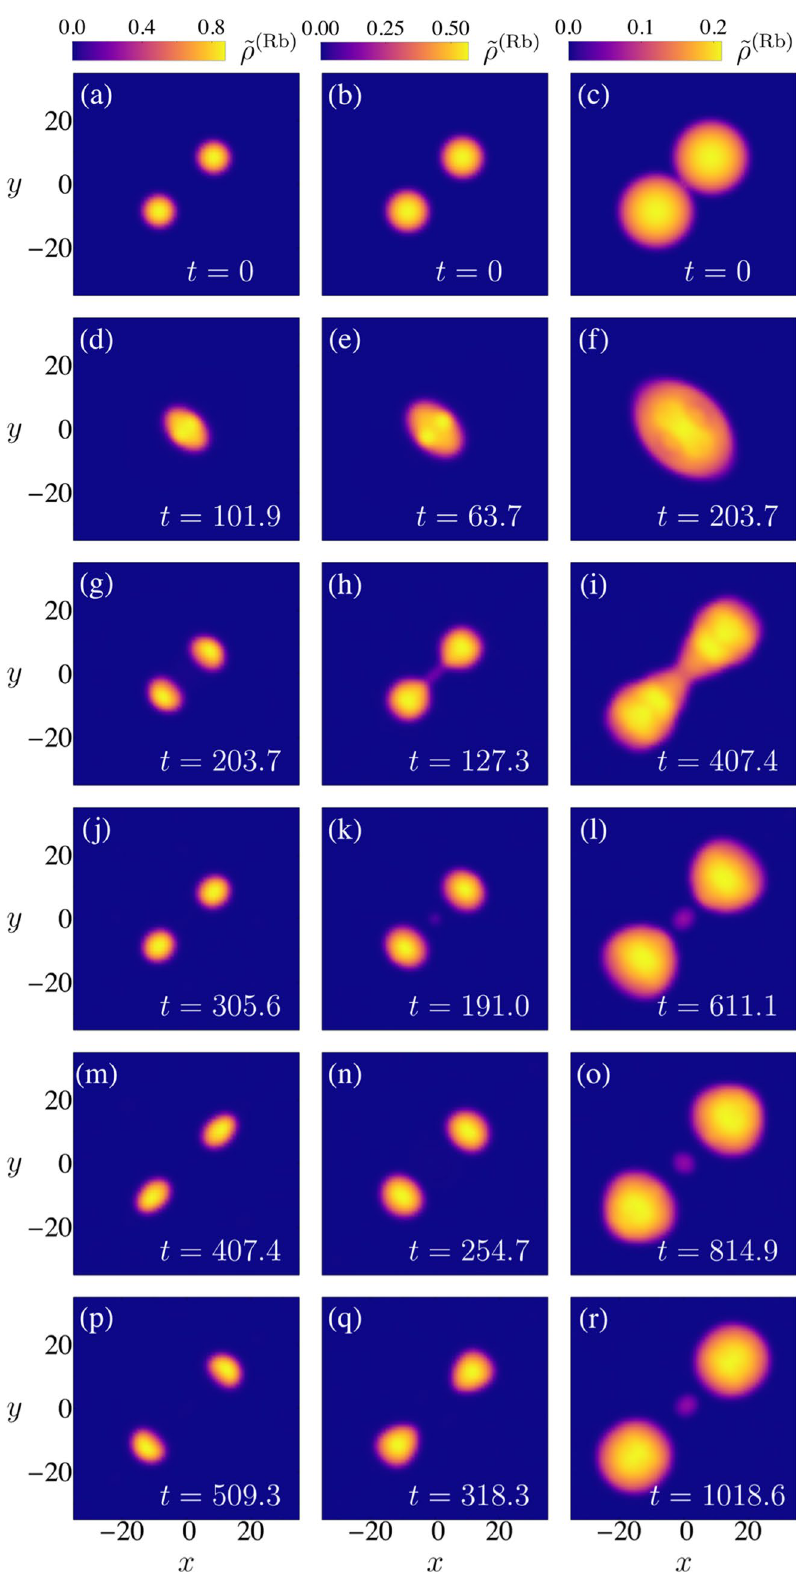
Figure 4. Illustrative examples of frontal collisions of two droplets leading to an initial coalescence followed by a disintegration of the resulting droplet into two droplets that are then expelled in opposite directions. Initially, identical hetero-nuclear droplets of Rb and K atoms are considered in each column, where the density of Rb atoms integrated along the dz ρ ( Rb ) ( x , y , z ) is depicted at different evolution times. The initial translational kinetic energy z-direction ˜ ρ ( Rb ) ( x , y ) = 5 6 6 is varied to guarantee that for N ( Rb ) = 5 × 10 (first column), N ( Rb ) = 1 × 10 (second column) and N ( Rb ) = 5 × 10 (cid:31) ( A 1 ) 14.5 (third column), the Weber number equals We 2 =